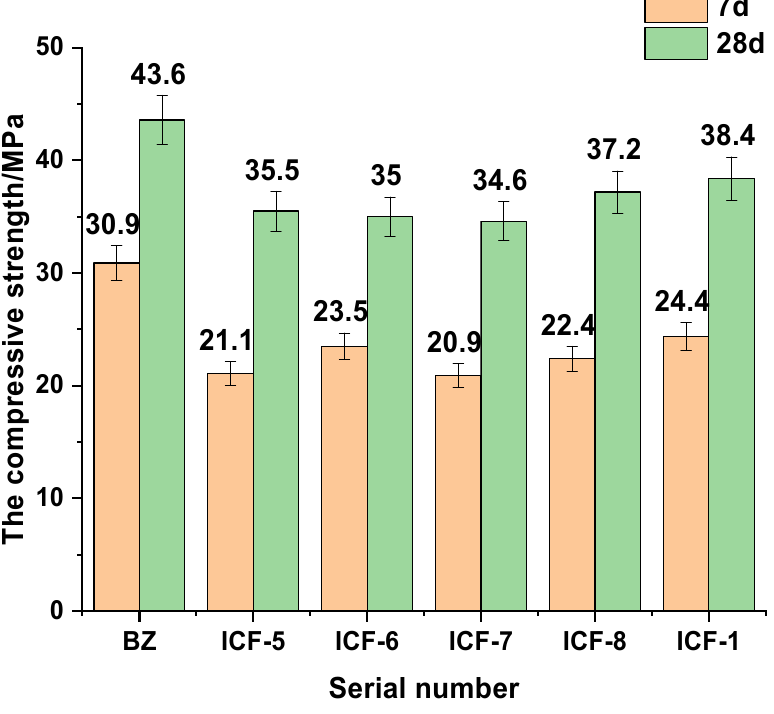
Figure 4. Compressive strength tests with different proportioning.